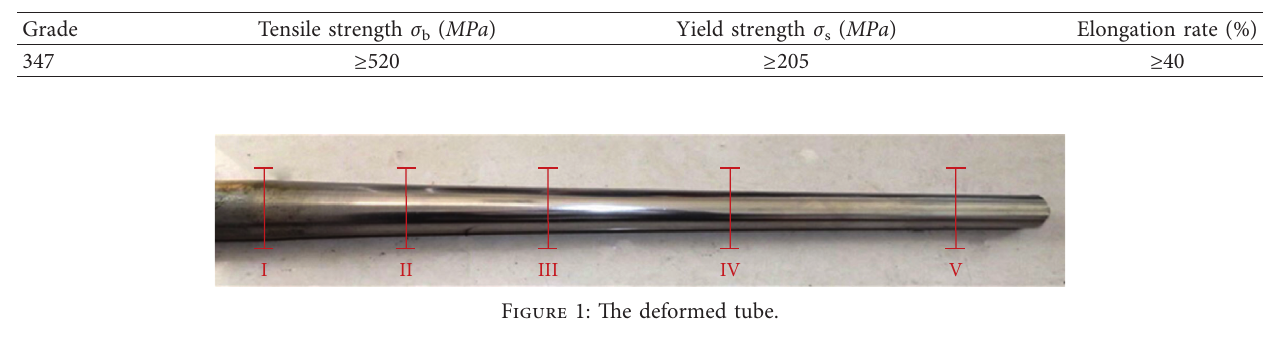
Table 1: The mechanical properties of 347 stainless steel.